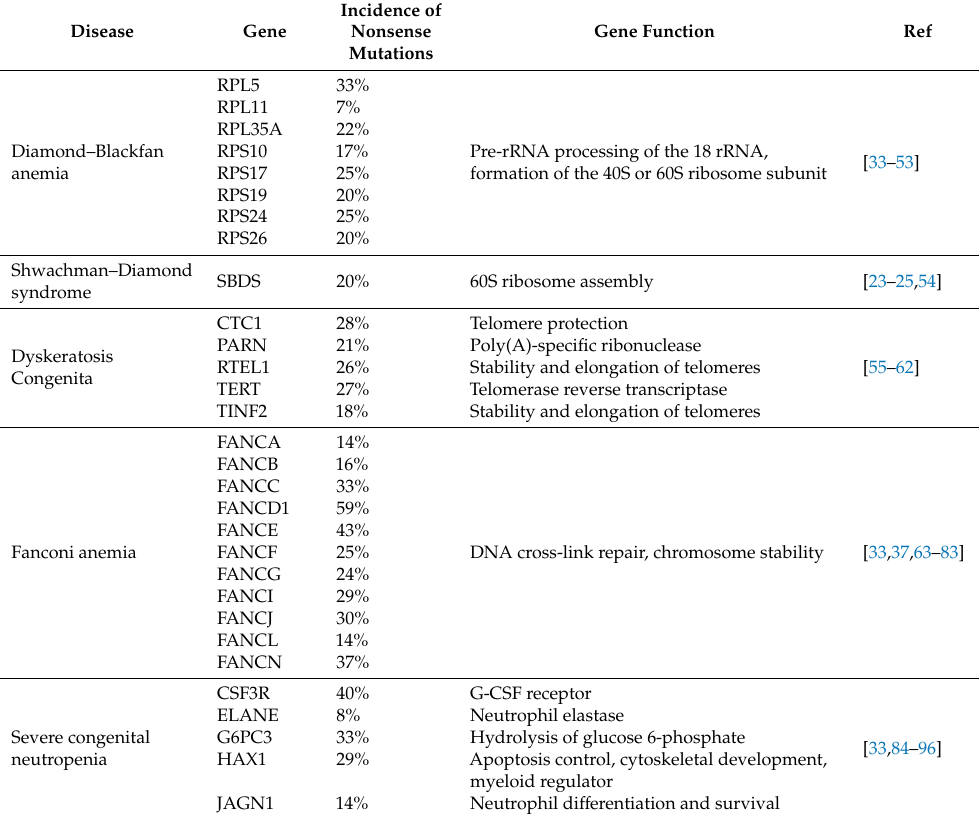
Table 1. IBMFS-associated genes mostly a ff ected by nonsense